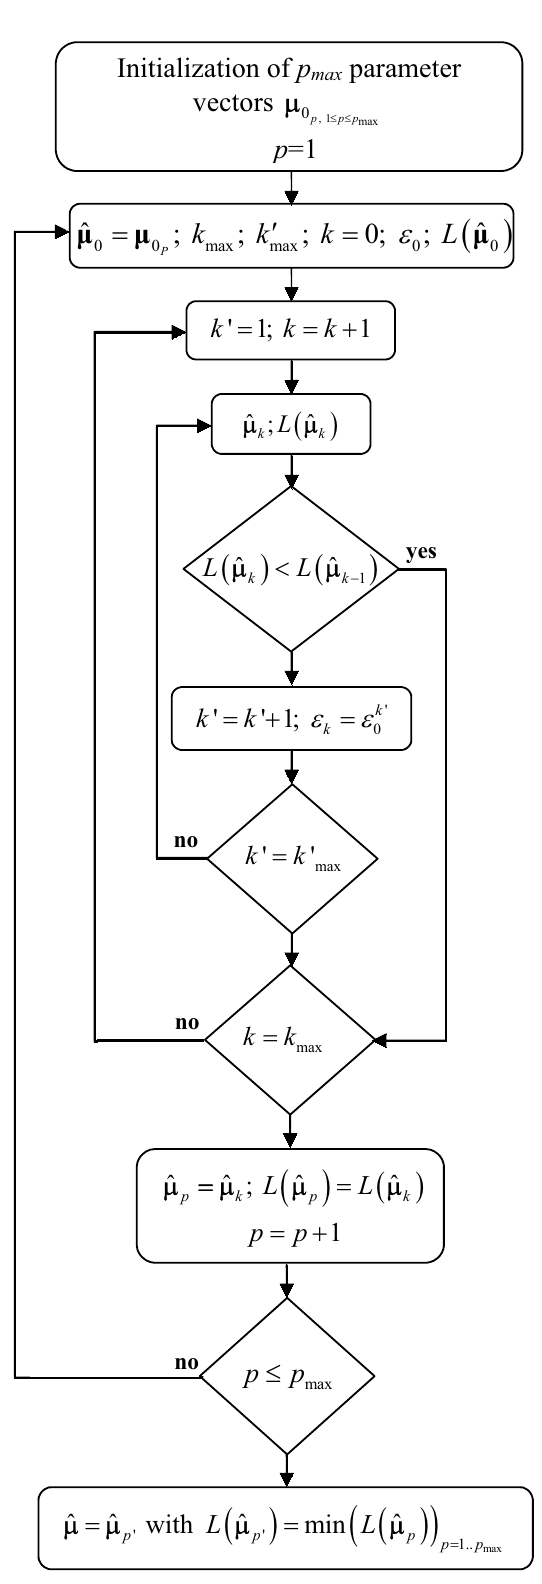
Fig. 1. Implementation of the SML algorithm.